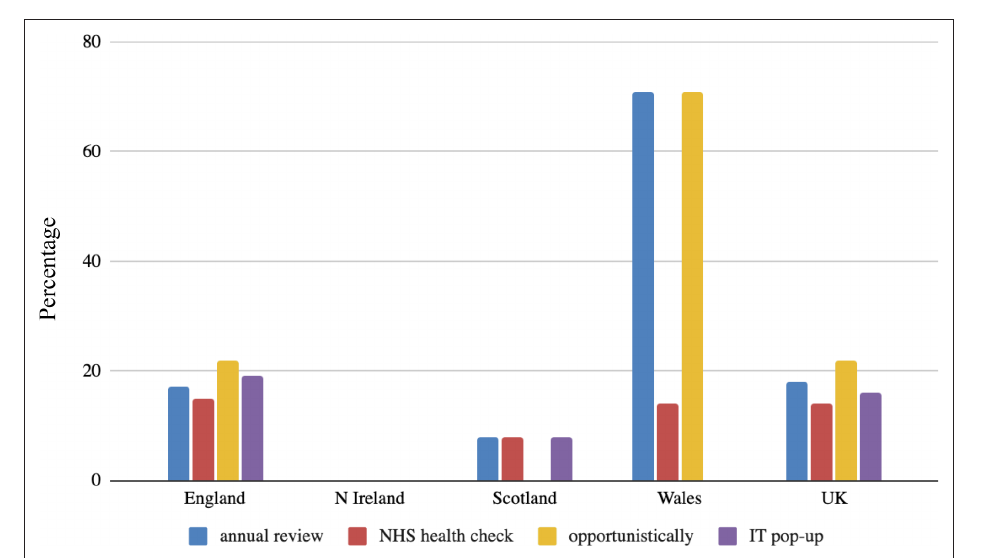
Figure 3 Percentage of clinical commissioning groups and health authorities using proactive methods to